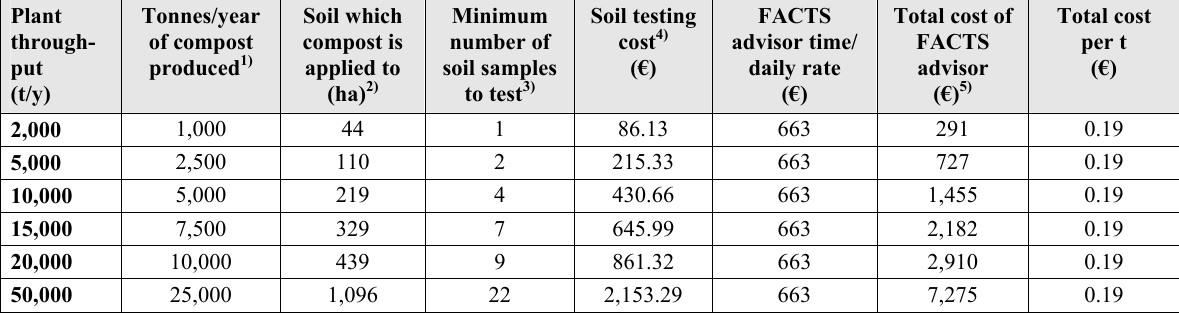
Table 25: Quality assurance costs for compost customers following the UK Quality